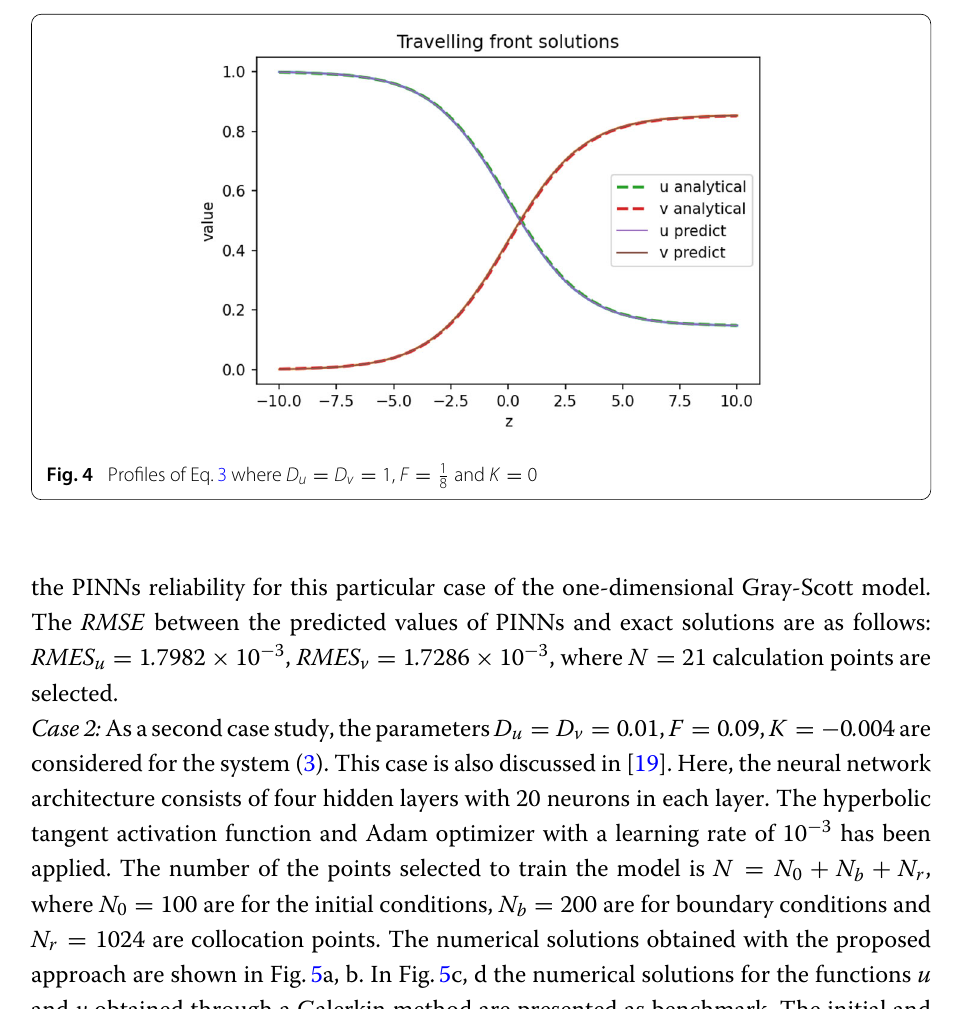
the PINNs reliability for this particular case of the one-dimensional Gray-Scott